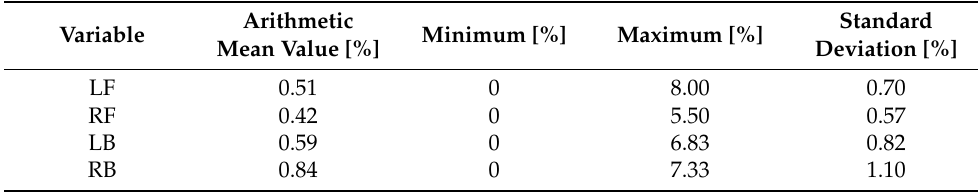
Table 4. Basic statistical values of variables LF, RF, LB, RB.